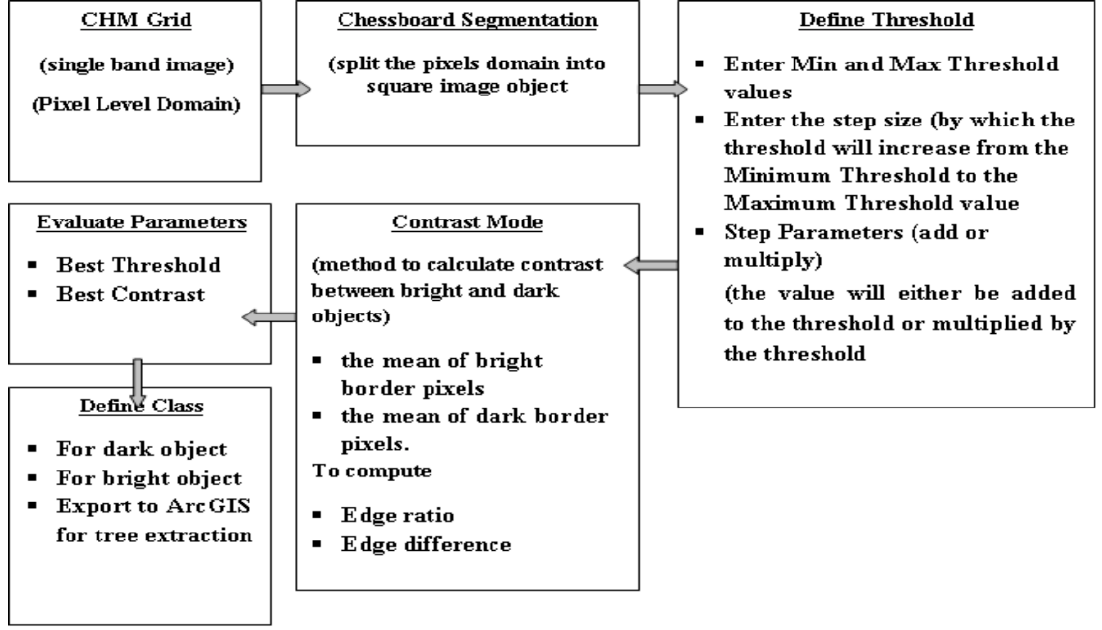
Figure 5. Contrast split segmentation steps applied on single band canopy height model (CHM) image to splits bright and dark objects based on a threshold that maximized the contrast between the resulting bright and dark objects.